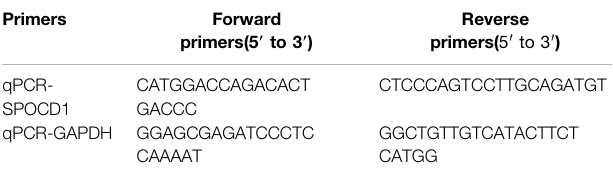
TABLE 1 | The primers of SPOCD1 and GAPDH.